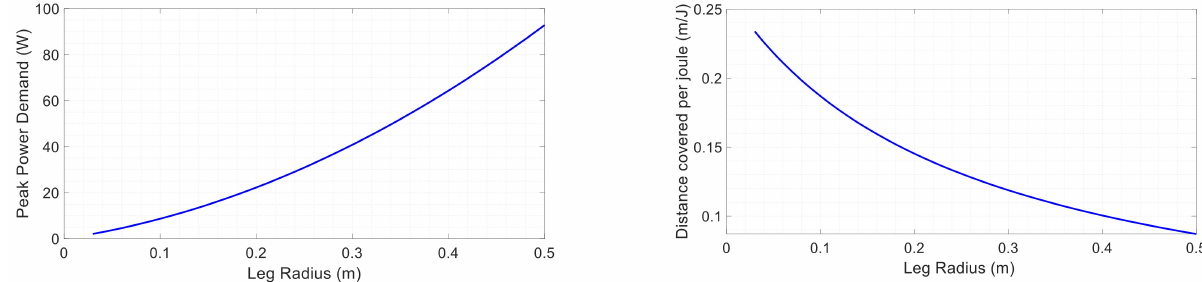
Figure 21. Peak power demand ( left ), and horizontal distance covered per joule consumed ( right ) when m = 1 kg, ω = 2 π and varying leg radius.